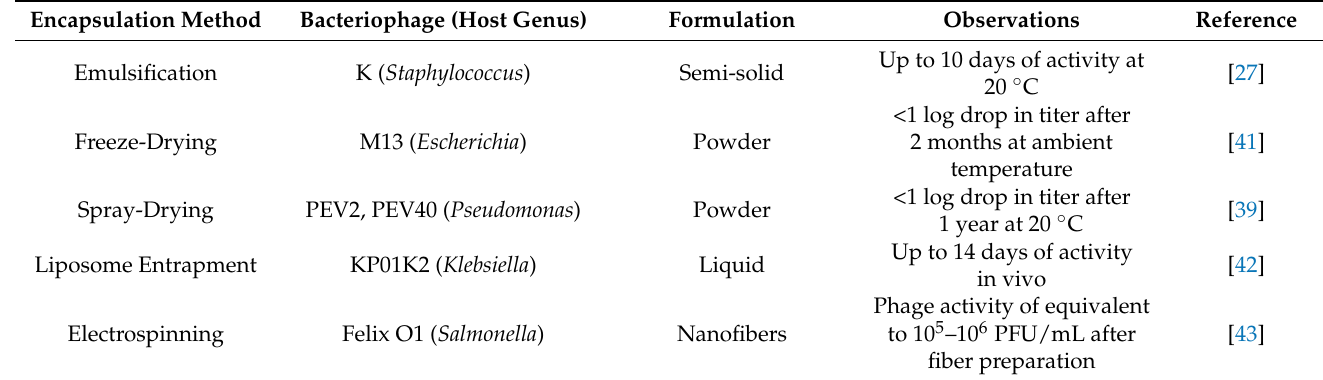
Table 1. Examples of the various encapsulation approaches that have been carried out with bacteriophages.